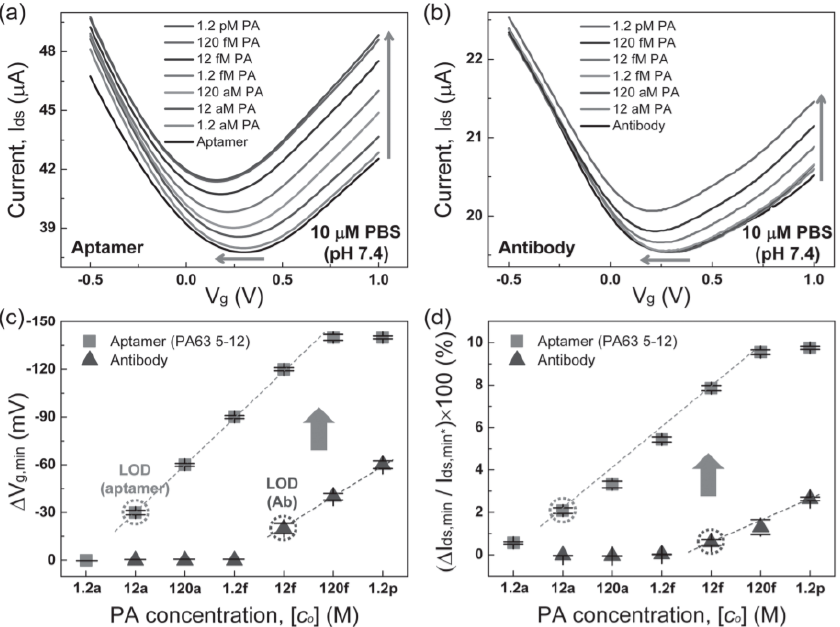
Figure 12. Transfer curves of a G-FET with increasing concentrations (depicted by the arrows) of protective antigen (PA) using an ( a ) aptamer and ( b ) antibody. These were then depicted as ( c ) Dirac voltage shift and ( d ) change in drain-source current. Reprinted from [48], Copyright 2013, with permission from John Wiley and Sons.